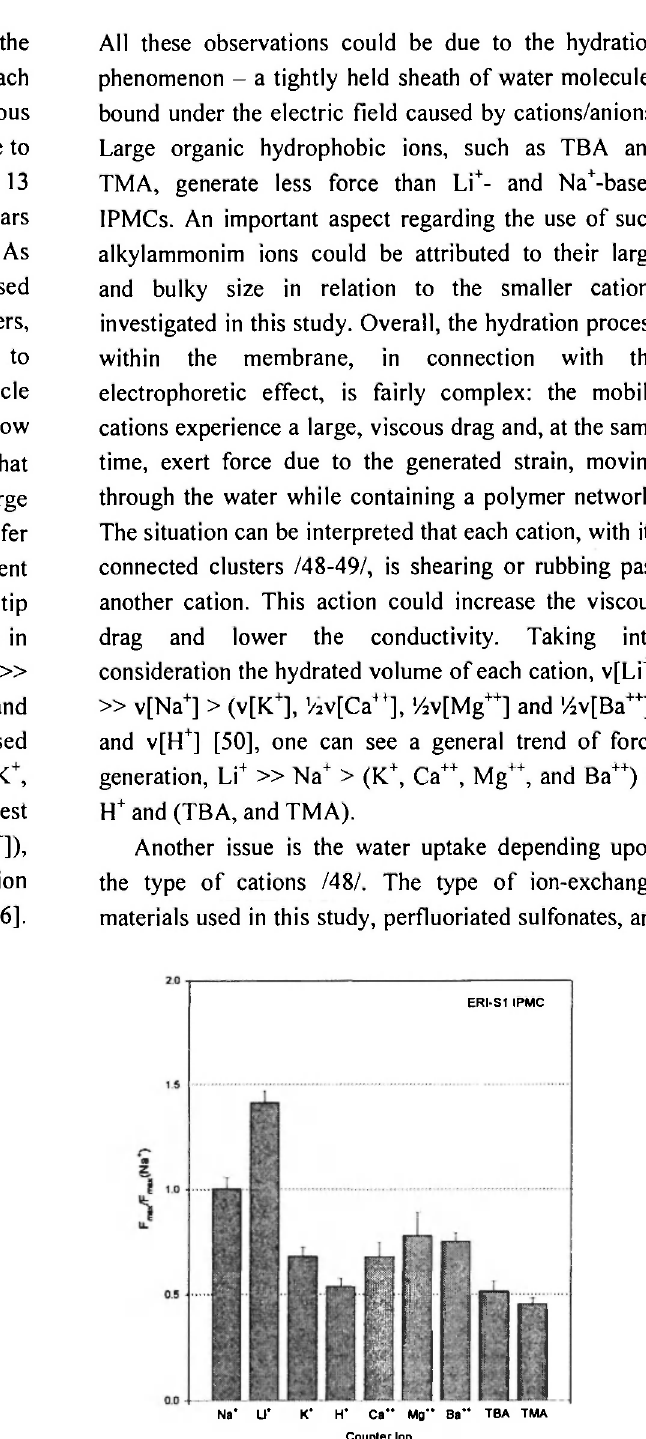
Fig. 8: Effects of various cations on the actuation of the IPMC muscle. Comparisons were made against Na + in terms of maximum force generated at zero displacement. A sinusoidal input voltage of 1.2 V nns and a frequency of 'Λ Hz were set for all experiments. The samples were cut in a standard size of 0.675 χ 2.54 cm. Na + was chosen as a reference since it is coordinated with four